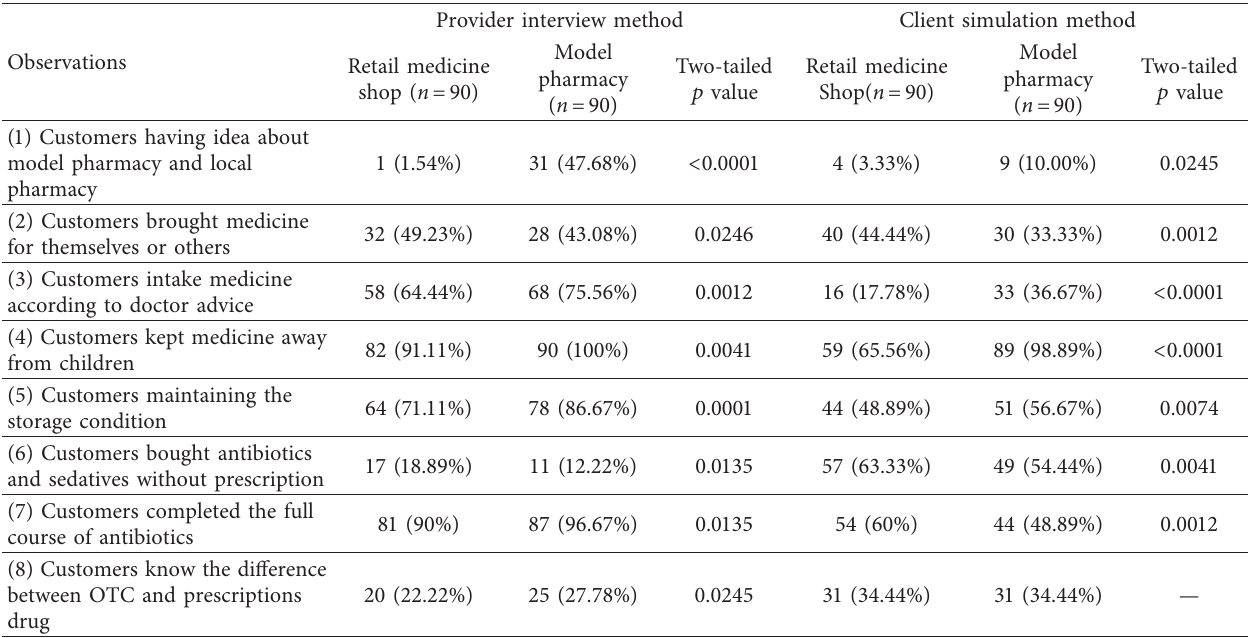
Table 4: Knowledge- and practice-based output from customers/clients from local and model pharmacies.